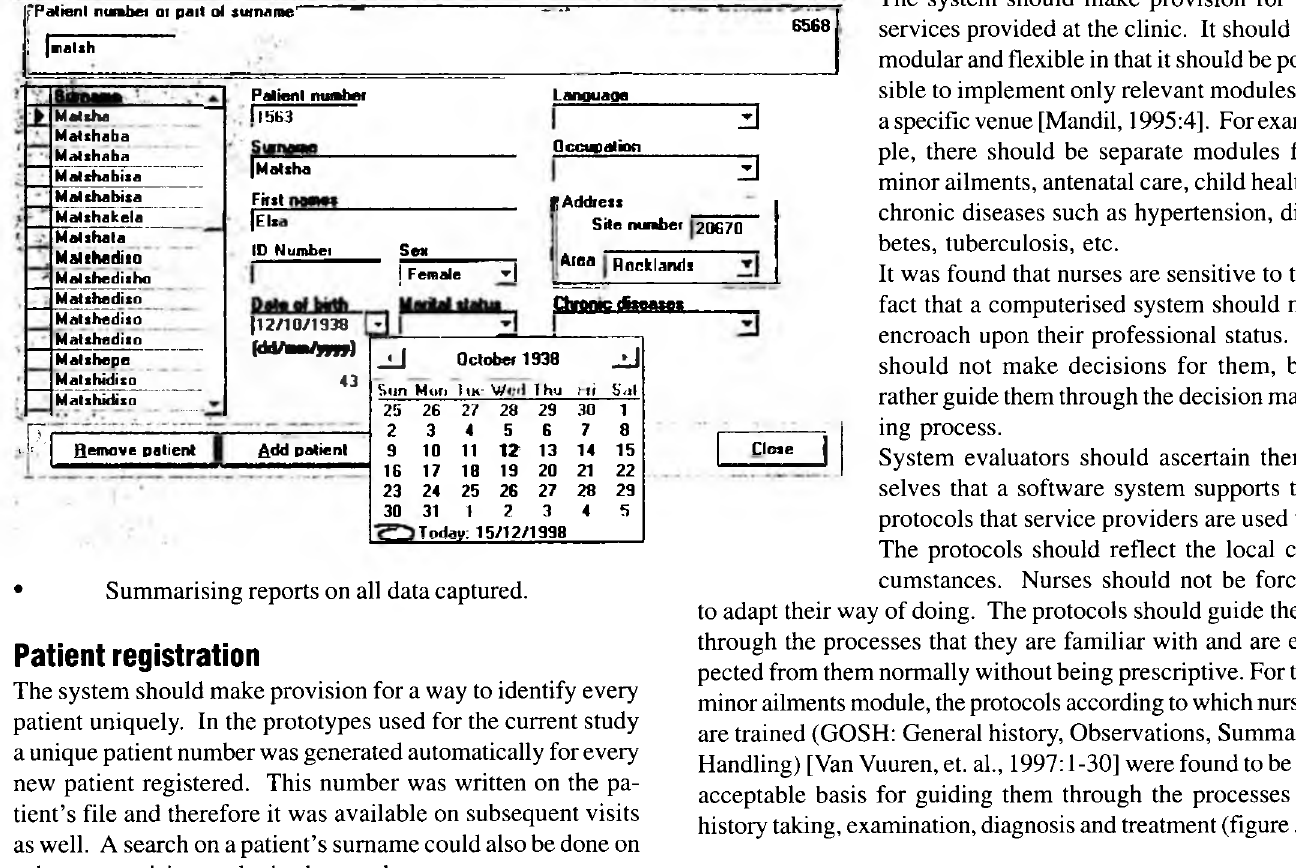
Figure 4 : Patient registration screen DEM0GHAPH1C DETAJL9